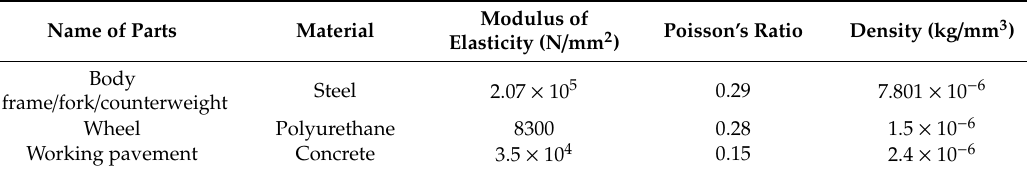
Table 2. Material property settings.